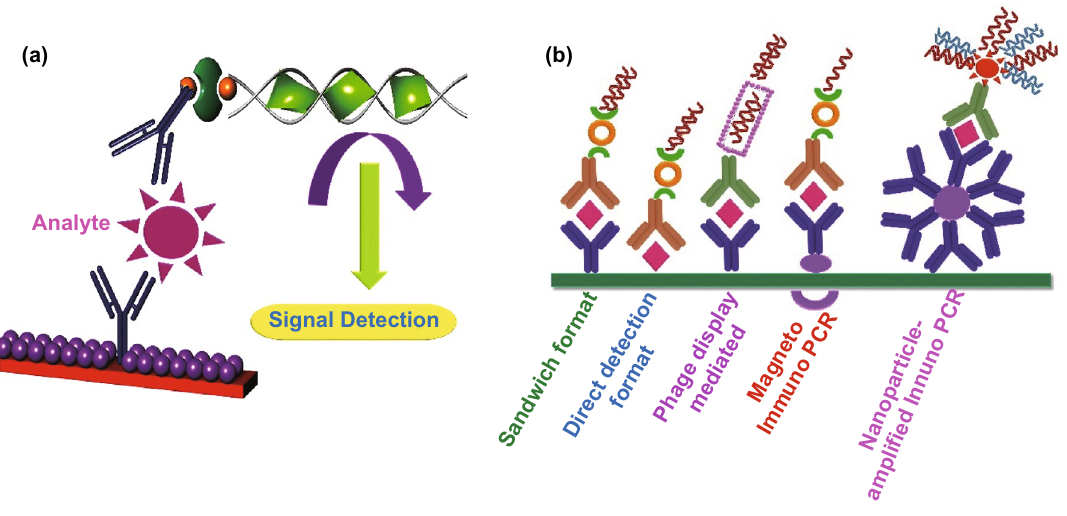
Fig. 7 a Immune‑PCR, the immuno‑PCR arrangement begins with a safe assay followed by PCR. Immuno‑PCR is parallel to ELISA with the exception that terminal DNA is augmented by a PCR; b different immune‑PCR platforms available, immuno‑PCR, the sandwich setup of immuno‑PCR, the direct setup of antigen detection, phage intermediated where single‑chain variable fragments (scFv), magneto immuno‑PCR, nanoparticle‑amplified immune PCR. Redrawn from Ref Front Microbiol. 2019; 10: 1957